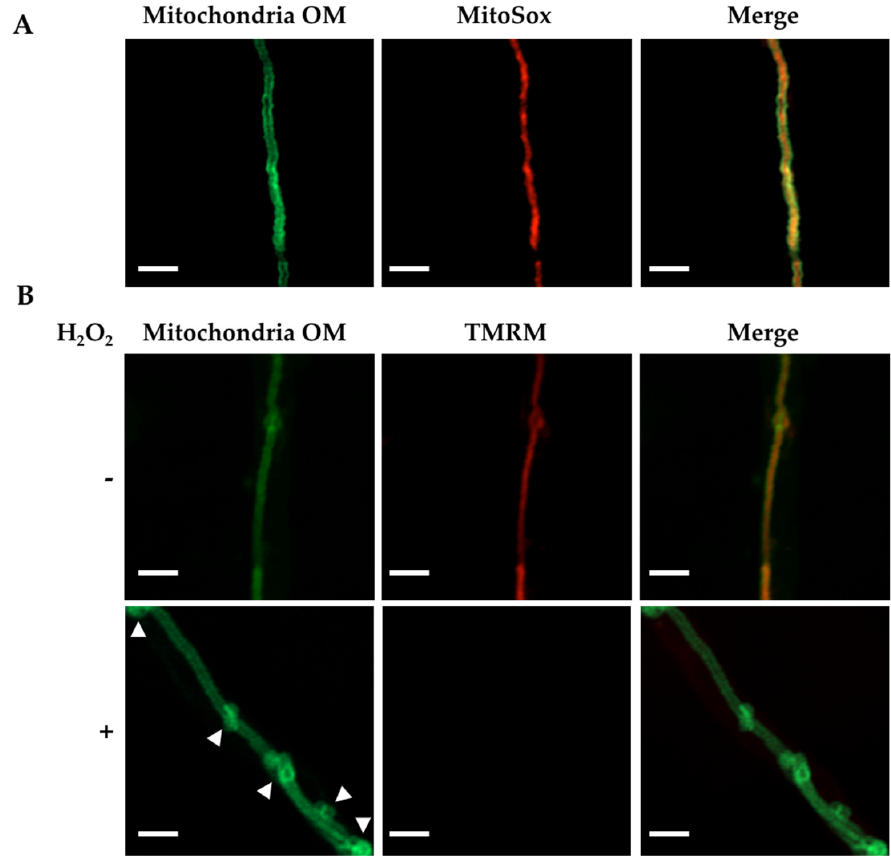
Figure 11. Tubular mitochondria from Δ mdmB heterokaryons show ROS accumulation, and in re- sponse to H 2 O 2 lose membrane potential and undergo the major reshaping of the outer mitochondrial membrane. ( A ) Mycelia from a slow-growing sector from a ∆ mdmB heterokaryon HVG3 colony grown on selective media for 5 days were stained with MitoSox for 10 min, rinsed with sterile water, and observed using Airyscan microscopy. ( B ) Mycelia obtained as in ( A ) were stained with TMRM for 20 min, rinsed with water, and treated or not with 5 mM H 2 O 2 for 30 min. The samples were observed using Airyscan microscopy. The white arrowheads indicate rearrangements of the mitochondrial outer membrane (OM). Scale bar = 5 µm.